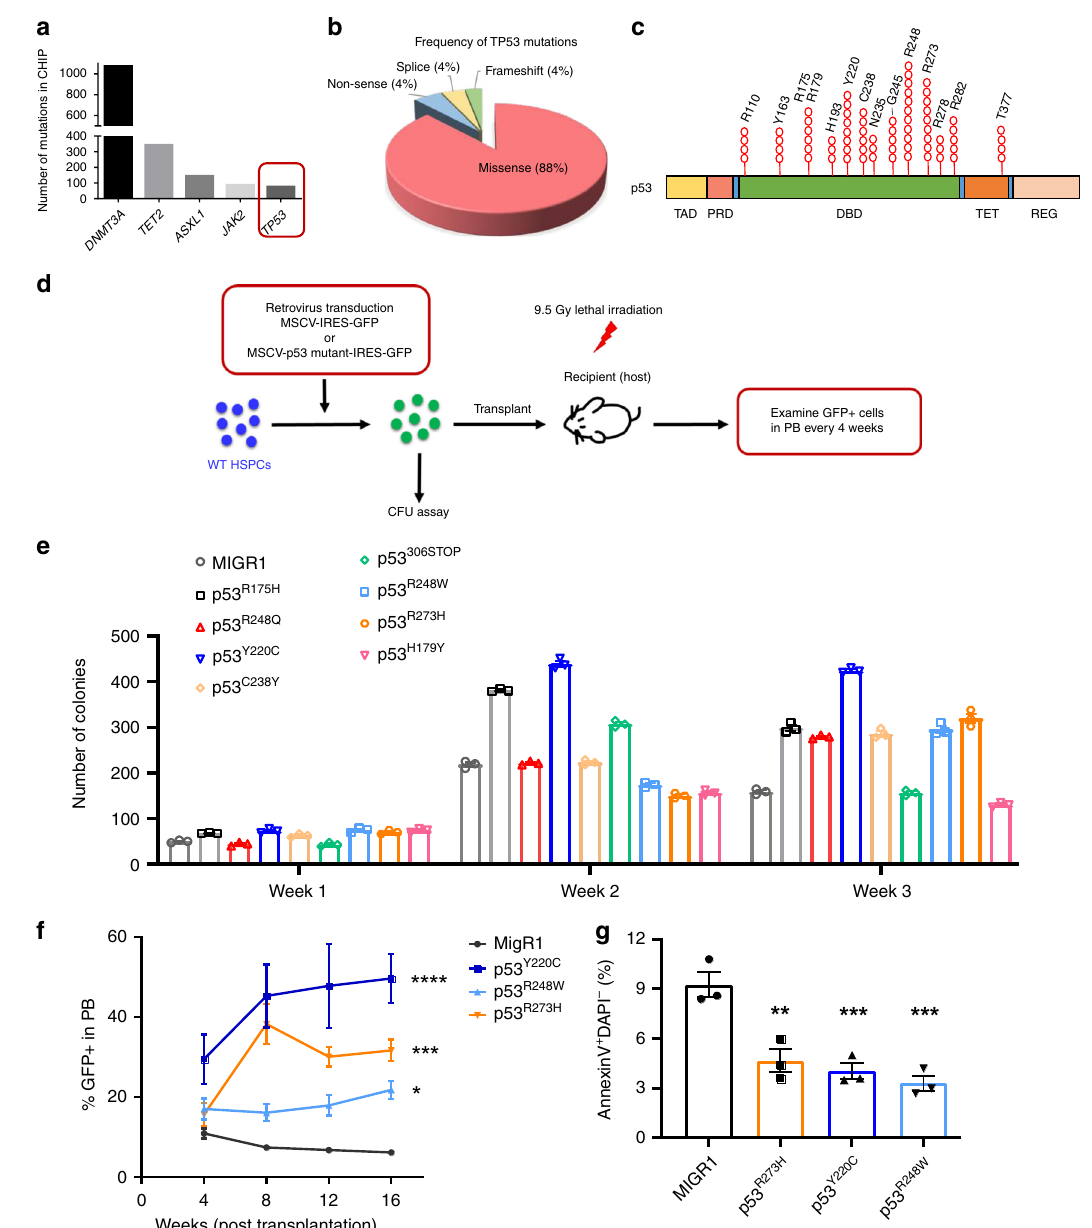
Fig. 1 TP53 mutations identi fi ed in CHIP enhance HSPC repopulating potential. a Tumor suppressor gene TP53 ranks in the top fi ve among genes that were mutated in clonal hematopoiesis with indeterminate potential (CHIP). b Pie chart representing different types of TP53 mutations identi fi ed in CHIP. c TP53 mutations in CHIP are enriched in the DNA-binding domain (DBD) of the p53 protein. TAD, transactivation domain; PRD, proline-rich domain; DBD, DNA-binding domain; TET, tetramerization domain; and REG, carboxy-terminal regulatory domain. d Several hot-spot TP53 mutations identi fi ed in CHIP were introduced into wild-type hematopoietic stem and progenitor cells (HSPCs) using retrovirus-mediated transduction. In vitro and in vivo stem and progenitor cell assays were then performed using sorted GFP (green fl uorescent protein)-postive cells. e Serial replating assays of HSPCs expressing different mutant p53 proteins. The methylcellulose cultures were serially replated, weekly, for 3 weeks; n = 3 independent experiments performed in duplicate. f Percentage of GFP + cells in the peripheral blood (PB) of recipient mice following competitive transplantation; n = 3 – 5 mice per group. g HSPCs expressing mutant p53 proteins were assessed for apoptosis at 24 h after radiation (2 Gy); n = 3 independent experiments. Data are represented as mean ± SEM. P -values were calculated using two-way ANOVA (analysis of variance) with Dunnett ’ s multiple comparisons test in e and f , one-way ANOVA with Dunnett ’ s multiple comparisons test in g ; * P < 0.05, ** P < 0.01, *** P < 0.001, **** P < 0.0001. Source data are provided as a Source Data fi LSKs and LT-HSCs in the BM of p53 − / − mice as reported 20 ; however, p53 R248W affects neither the frequency nor the number (Fig. 2e). Thus, mutant p53 does not affect the frequency, quiescence, or the survival of HSPCs when expressed at of HSPCs in the BM (Fig. 2a, b, and Supplementary Fig. 1b, c). physiological levels. While loss of p53 decreases the quiescence of LSKs and LT- Hematopoietic transplantation is a cellular stressor that has HSCs 20 , mutant p53 does not affect HSPC quiescence (Fig. 2c, d). been shown to promote the expansion of mutant HSPCs 12,35,36 .